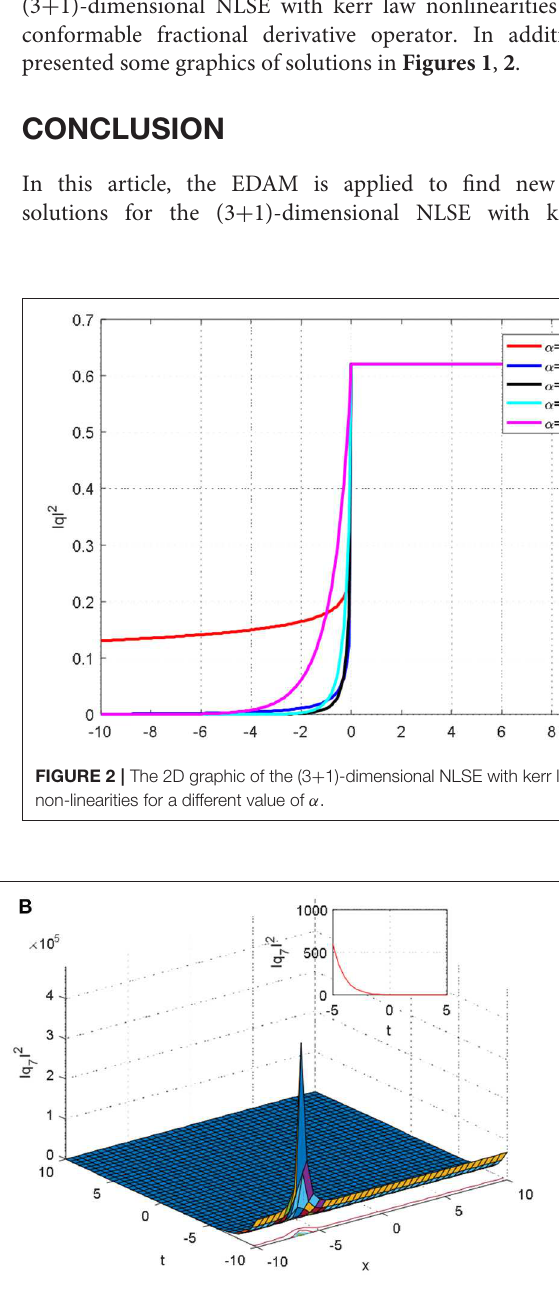
FIGURE 1 | The surface and 2D graphic for the (A) Frontiers in Physics |